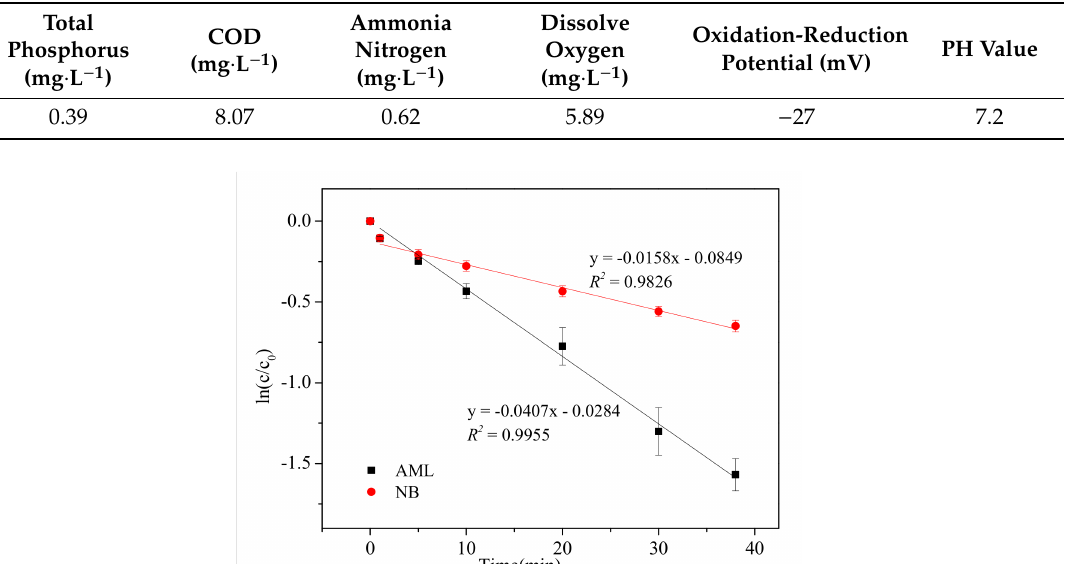
Table A1. General water quality parameters of the real water.